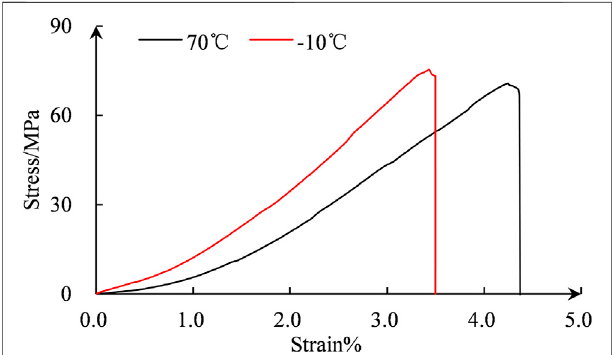
FIGURE 5 | Axial stress – strain curves of sandstone under different temperature